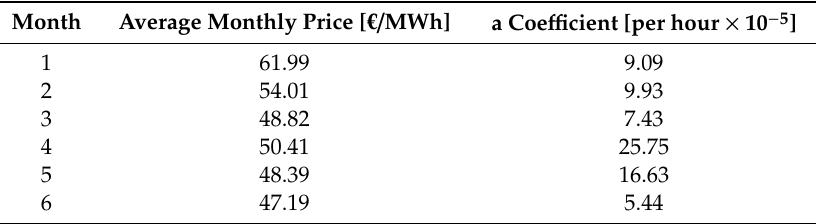
Table 2. Average monthly price obtained from the daily sales price for 2019 in Spain and the best-fit loss coe ffi cients per month for the polycrystalline